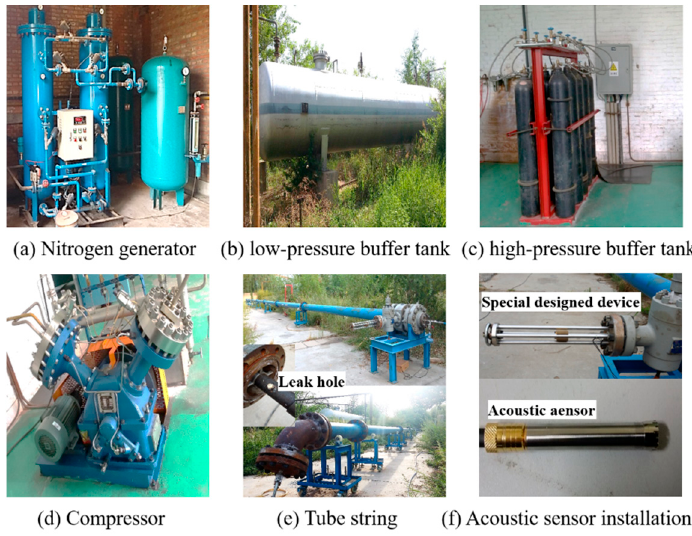
Figure 7. Pictures of the experimental system.